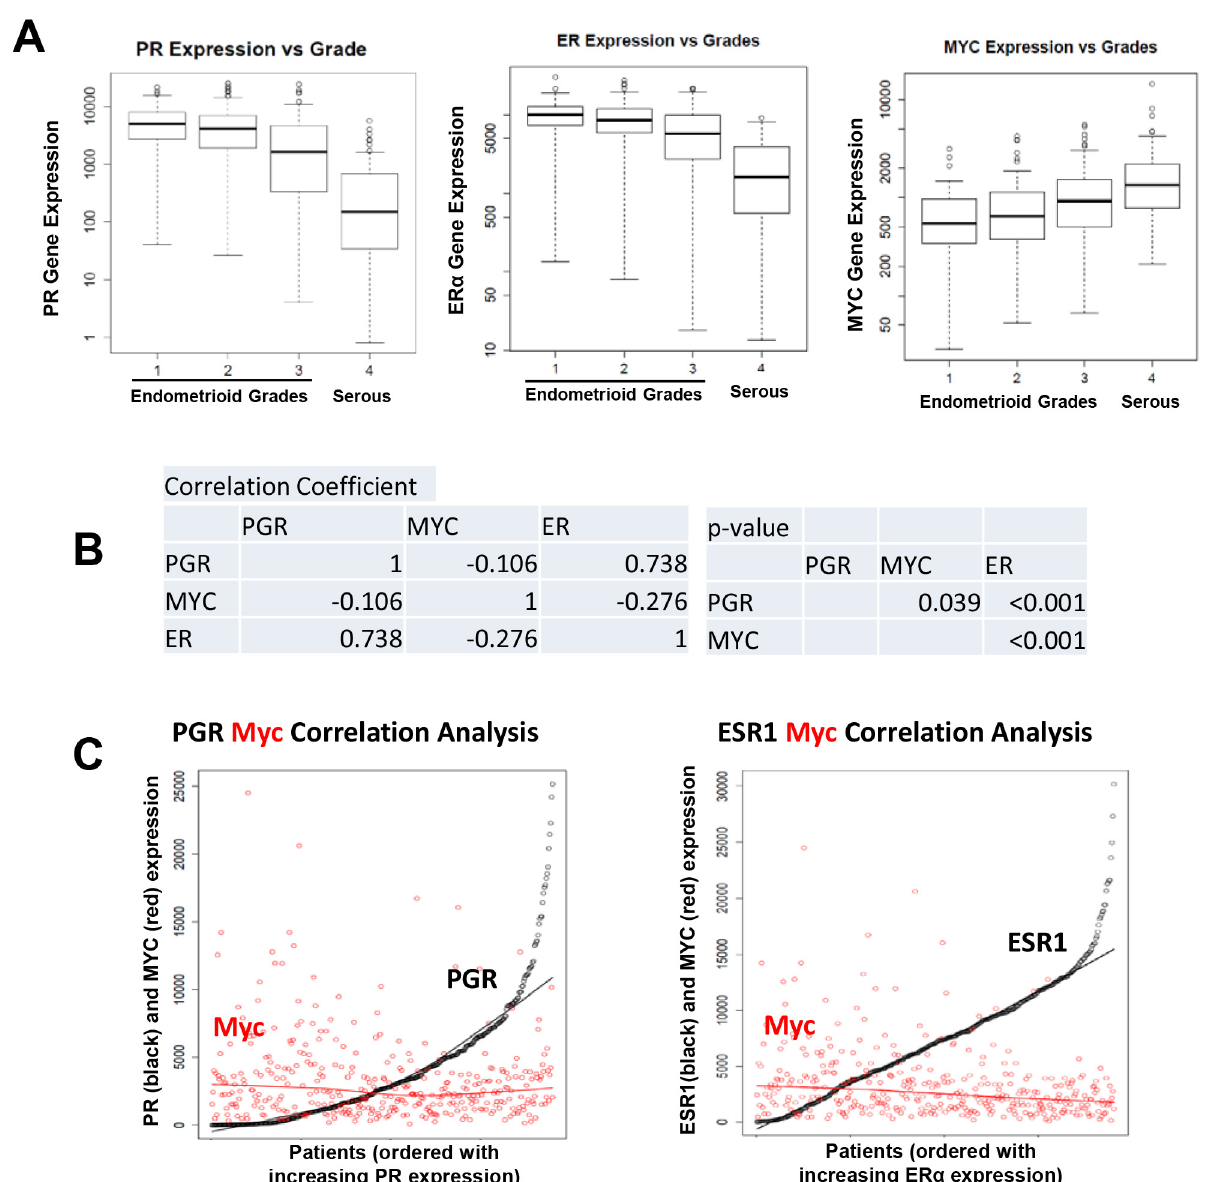
Fig 7. Inverse correlation of Myc with ESR1 and PGR in endometrial cancer TCGA data. (A) Boxplot of mRNA expression of PGR (left panel), ESR1 (middle panel) and Myc (right panel) was analyzed according to endometrial cancer grade in 379 endometrial cancer patient tumors from TCGA database. Patients were divided into four groups: endometrioid type I grade 1 (G1, n = 86), grade 2 (G2, n = 103), grade 3 (G3, n = 123) and serous type II grade 3 (G3, n = 67). (B) Pairwise correlation analysis of PGR, ESR1 and Myc mRNA levels using Spearman method. The correlation coefficients and p values are shown. (C) Scatterplot to show the negative correlation in expression of two genes. Patients were plotted on the x-axis in order of increasing expression of a specific gene. Two regression lines were produced by simple linear regression analysis based on the expression of respective genes. Left: Expression of Myc (red) against PGR (black); right: expression of Myc (red) against ESR1